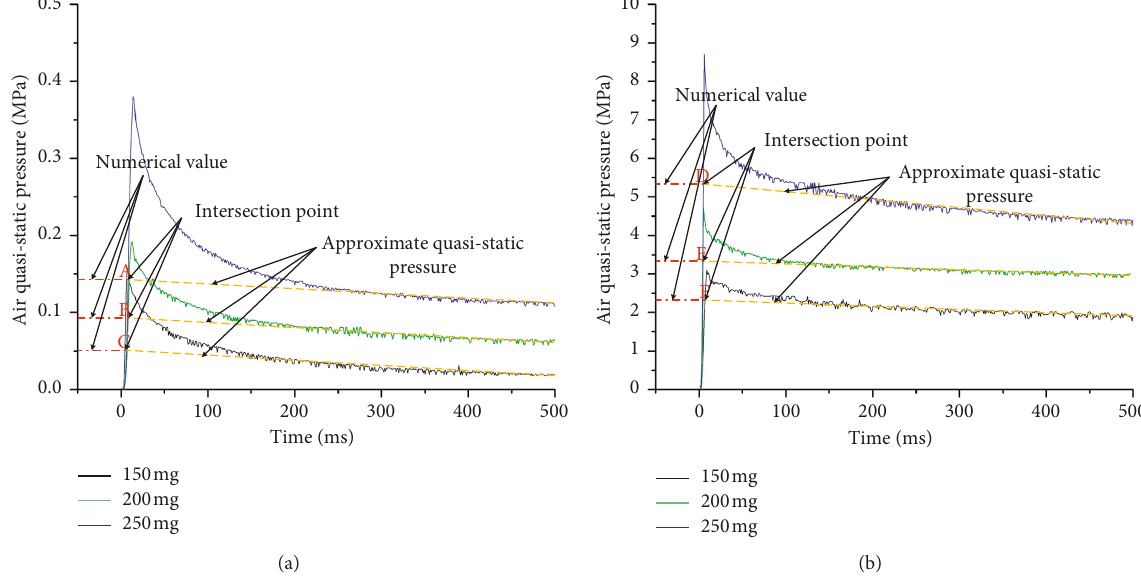
Figure 8: Method for measuring quasi-static pressure from (a) noncoupled air charging and (b) noncoupled water